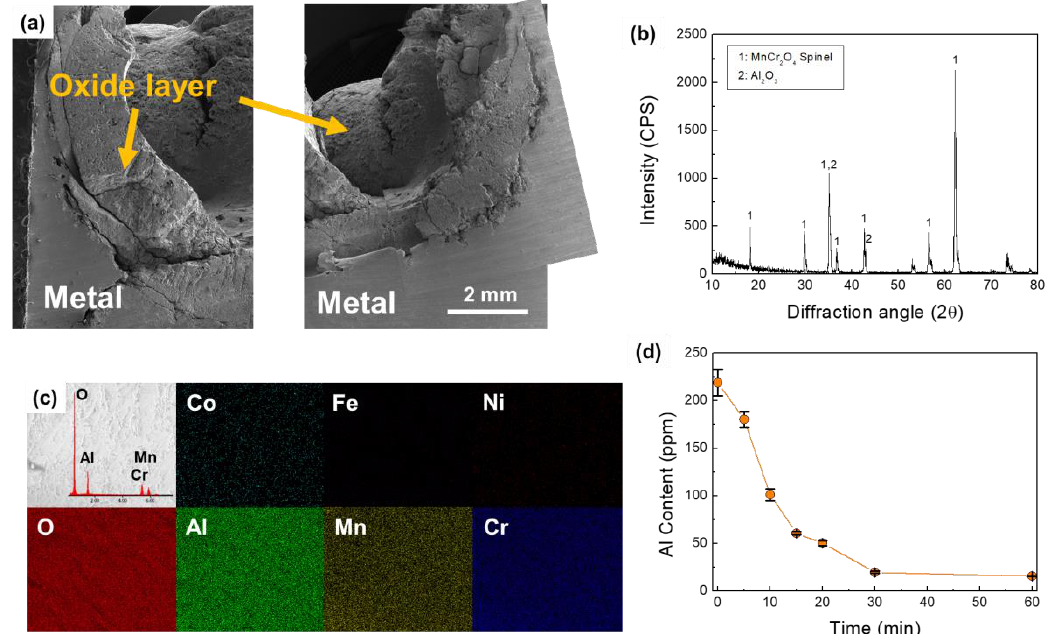
Figure 3. The oxide layer formed due to air exposure during the manufacturing of AE-HEA. ( a ) Macroscopic images of the oxide layer after the experiment, ( b ) XRD patterns of the layer, ( c ) EDS mapping images of the layer, and ( d ) Al content in the melt according to air exposure time.